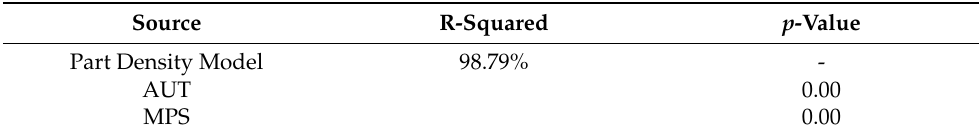
Table 3. Summary statistics for the Part Density MLR model.